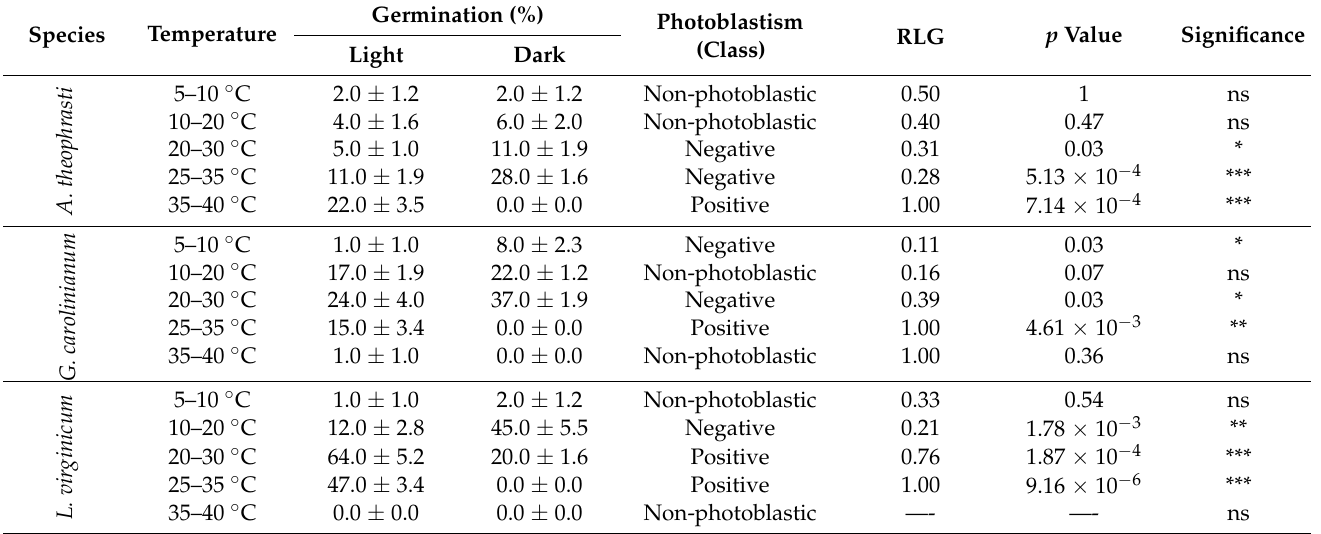
Table 3. Germination in light and dark treatments of the nine invasive species at five different tem- perature regimes. Photoblastism (class) and relative light germination index (RLG) were calculated as proposed by Milberg et al. [37] and Flores et al. [38]. The p -value denotes the significance of germination in light and dark treatments at p ≤ 0.001 (***), p ≤ 0.01 (**), p ≤ 0.05 (*), or not significant